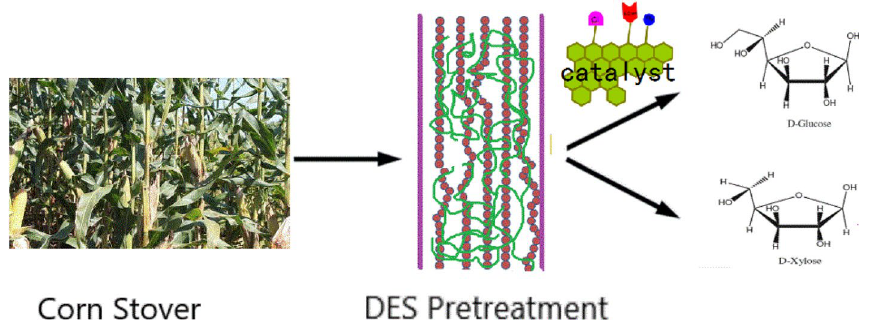
Fig. 1 Hydrolysis of MCC pre- treated by different solvents. Reaction conditions: 0.05 g MCC, 0.1 g solid acid catalyst and 4 mL deionized water, 363